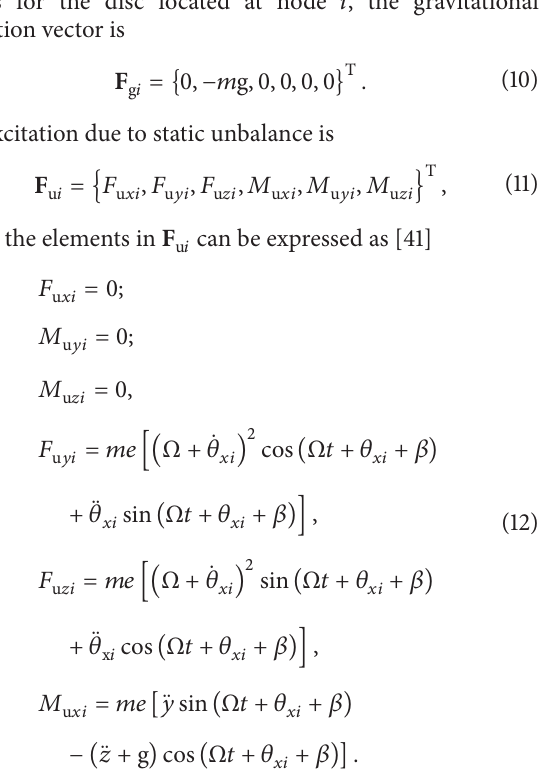
Once the CCL is ascertained, the stiffness matrix of the crack element can be